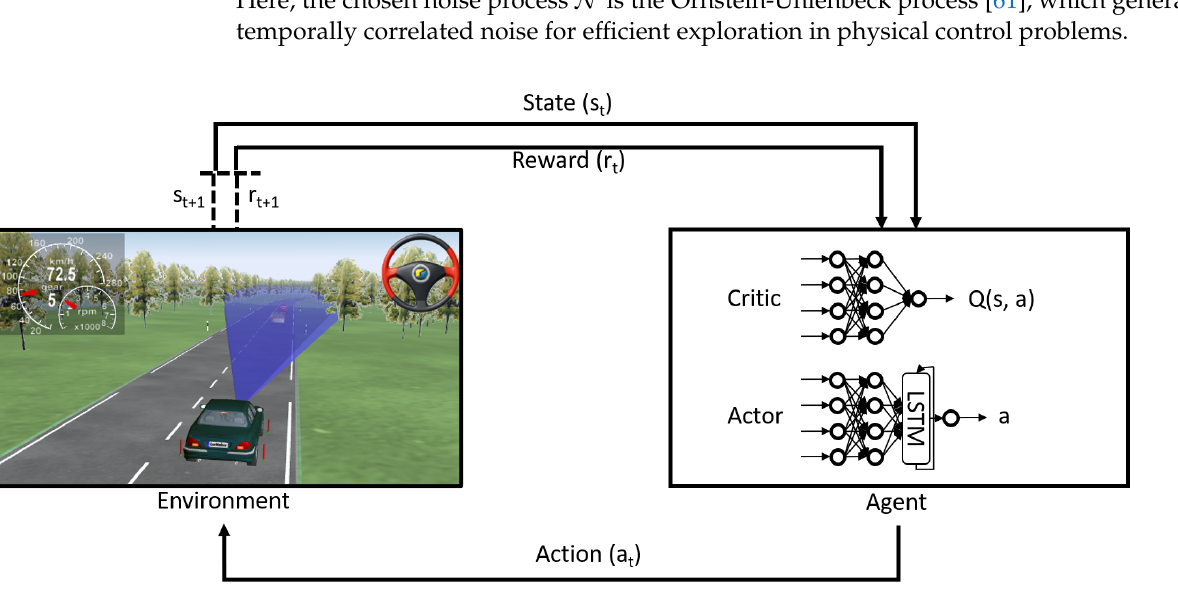
Figure 1. Reinforcement learning